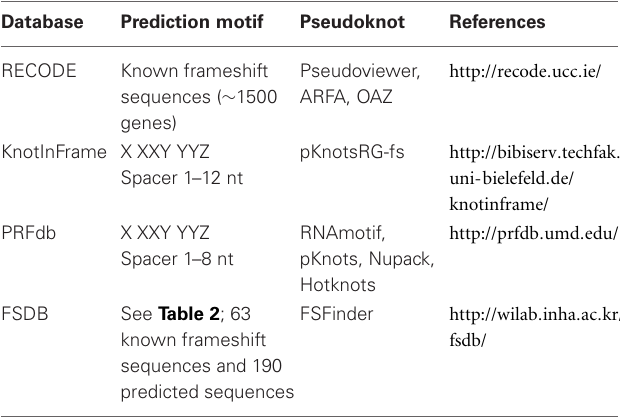
Table 1 | Databases for prediction of − 1 and + 1 frameshifting.